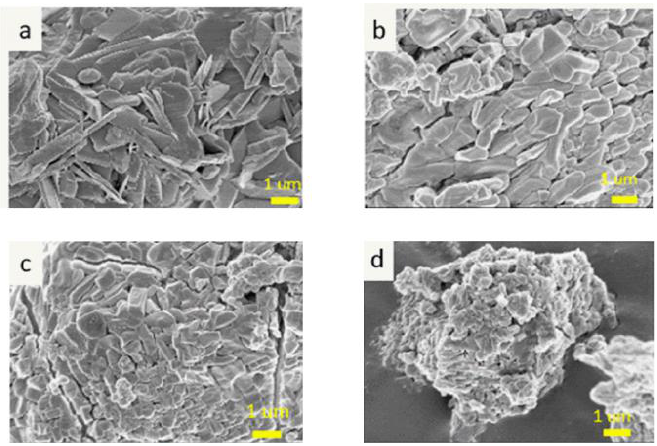
Figure 1. SEM images of MgKPO 4 ·6H 2 O prepared with different magnesia/KH 2 PO 4 molar ratios = ( a ) 2, ( b ) 3, ( c ) 4, and ( d ) 5. ratios = ( a ) 2, ( b ) 3, ( c ) 4, and ( d )